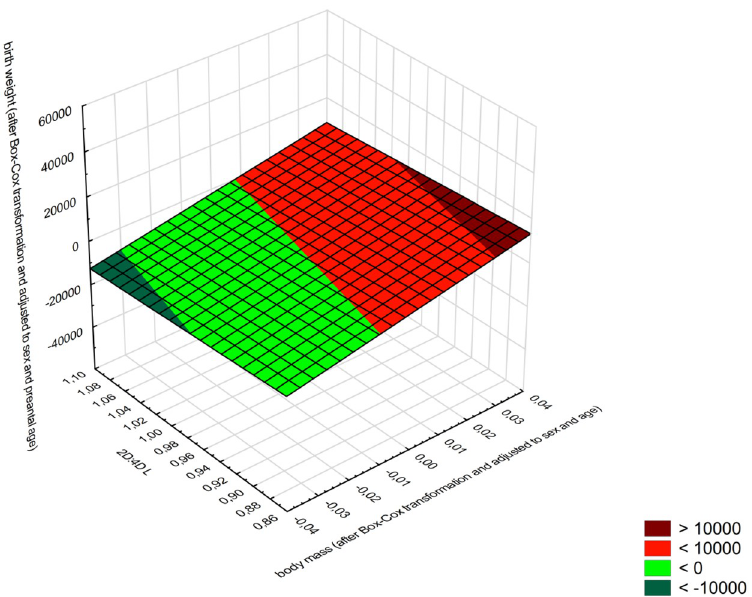
Fig 4. Relationship between 2D:4D L birth weight (adjusted for sex and gestational age) and body weight during postnatal ontogenesis (adjusted for sex and chronological age) in boys.